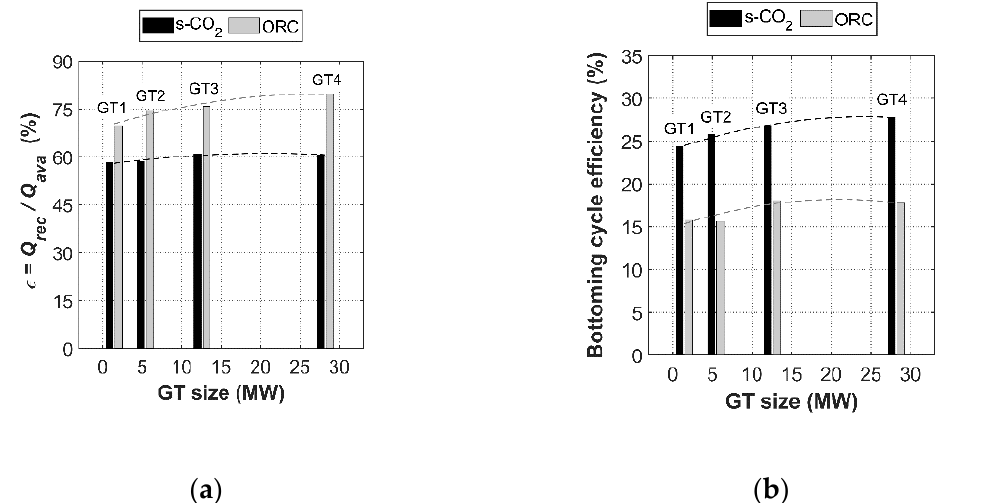
Figure 6. Bottoming cycles design performance: ( a ) heat recovery efficiency; ( b ) bottoming cycle efficiency.